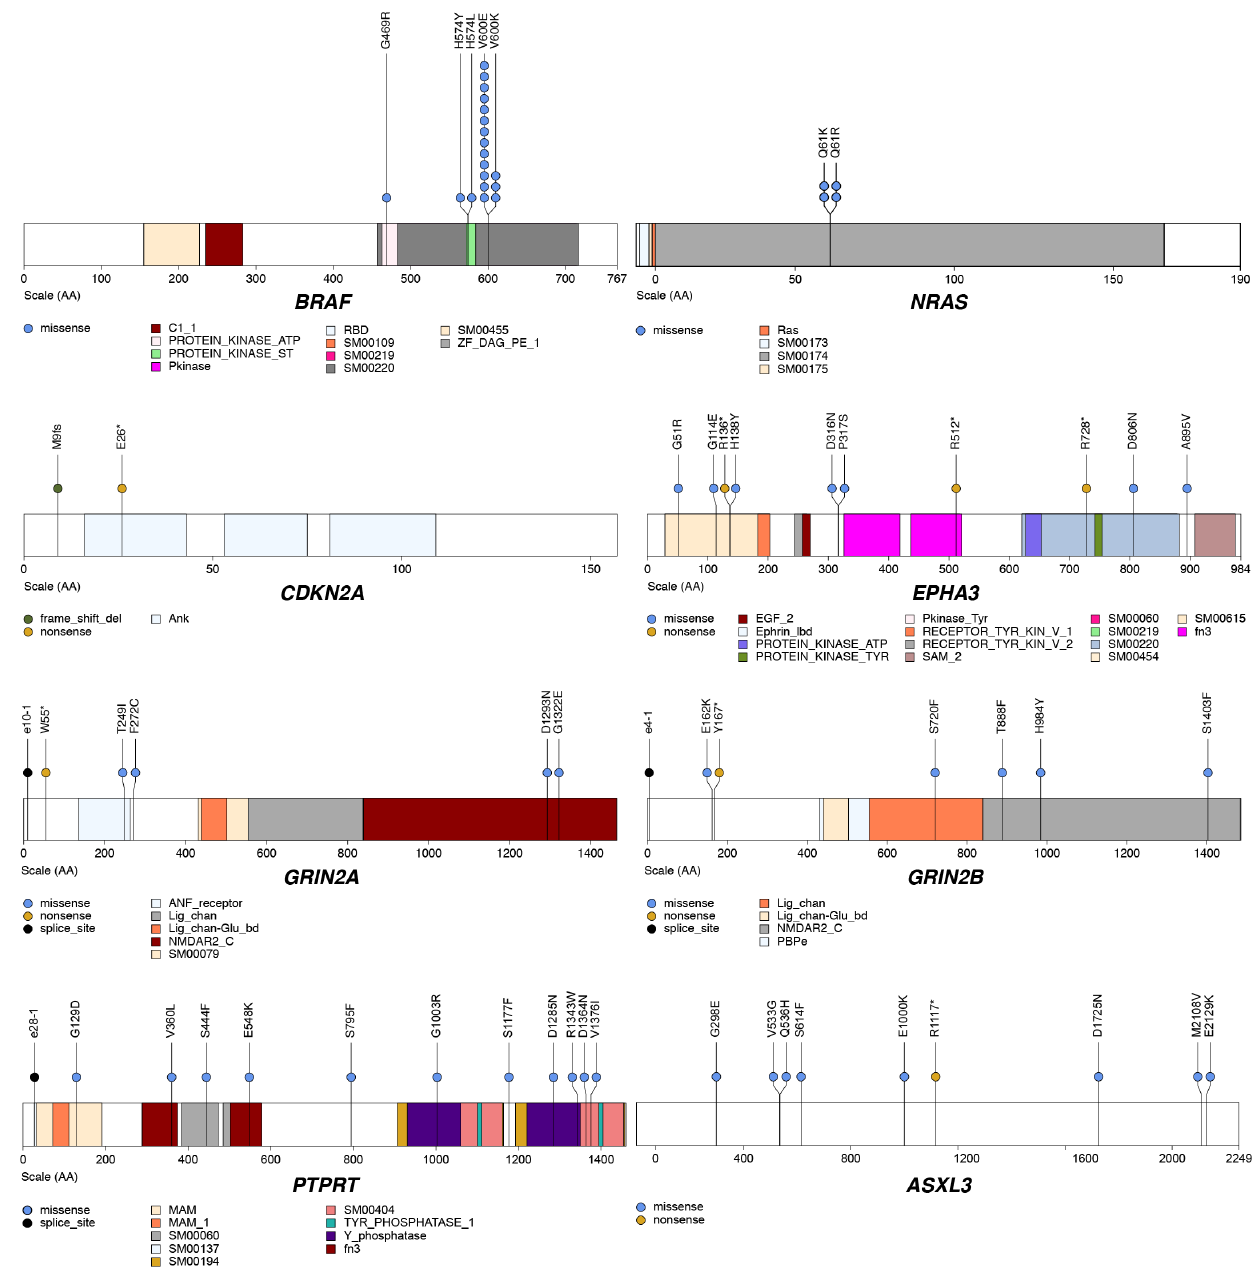
Figure 2. Mutation distribution in BRAF , NRAS , CDKN2A , EPHA3 , GRIN2A , GRIN2B , PTPRT , and ASXL3 . The locations of conserved protein domains are highlighted. Each nonsynonymous substitution, splice site mutation, or indel is designated with a circle at the representative protein position with color to indicate the translational effects of the mutation.